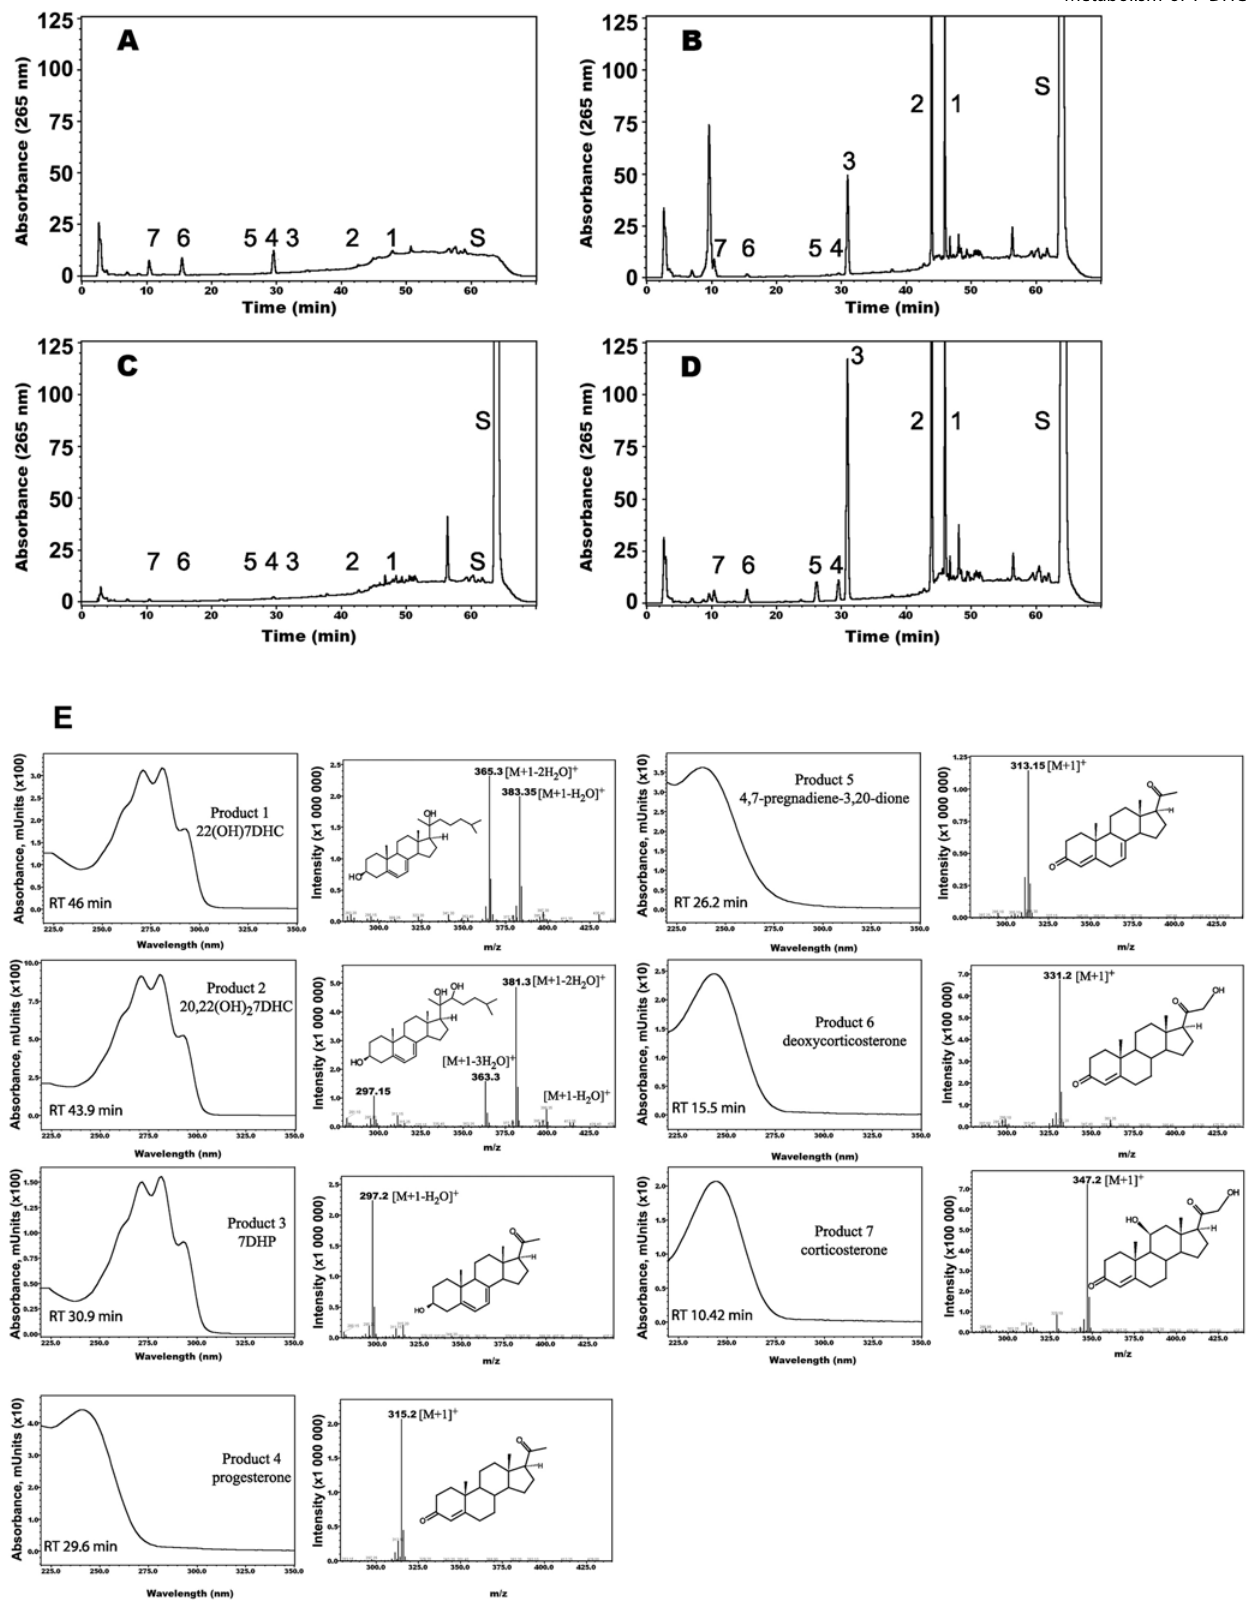
Figure 1. 7DHC metabolism by rat adrenal glands. Finely cut fragments of rat adrenal glands were incubated in the presence ( B–D ) or absence ( A ) of 7DHC (0.5 mM). Boiled adrenal fragments ( C ) served as an additional negative control. Panel B shows results from an incubation which included trilostane, a 3 b HSD inhibitor. Steroids were extracted with methylene chloride and subjected to LC/MC and UV spectra analyses. Panels A–D identifies 7 main products. Product 3 had an identical retention time to 7DHP standard. Panel E shows UV spectra, MS and the predicted structures of the 7 metabolites. doi:10.1371/journal.pone.0004309.g001 PLoS ONE | www.plosone.org